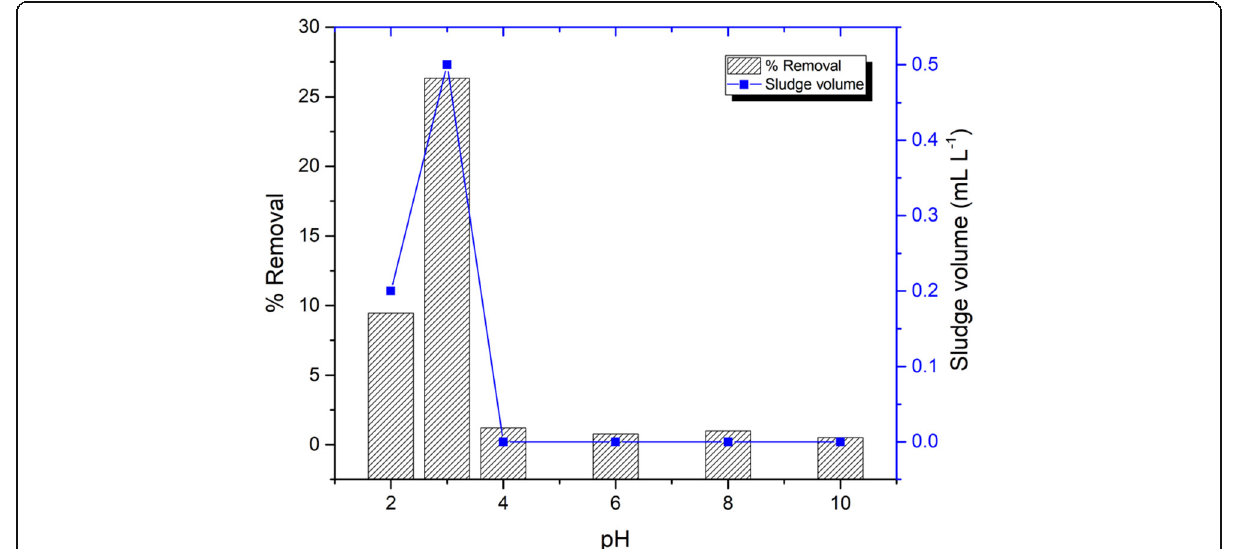
Fig. 3 The effect of pH to the coagulation performance (coagulant dosage 60 mg L − 1 )